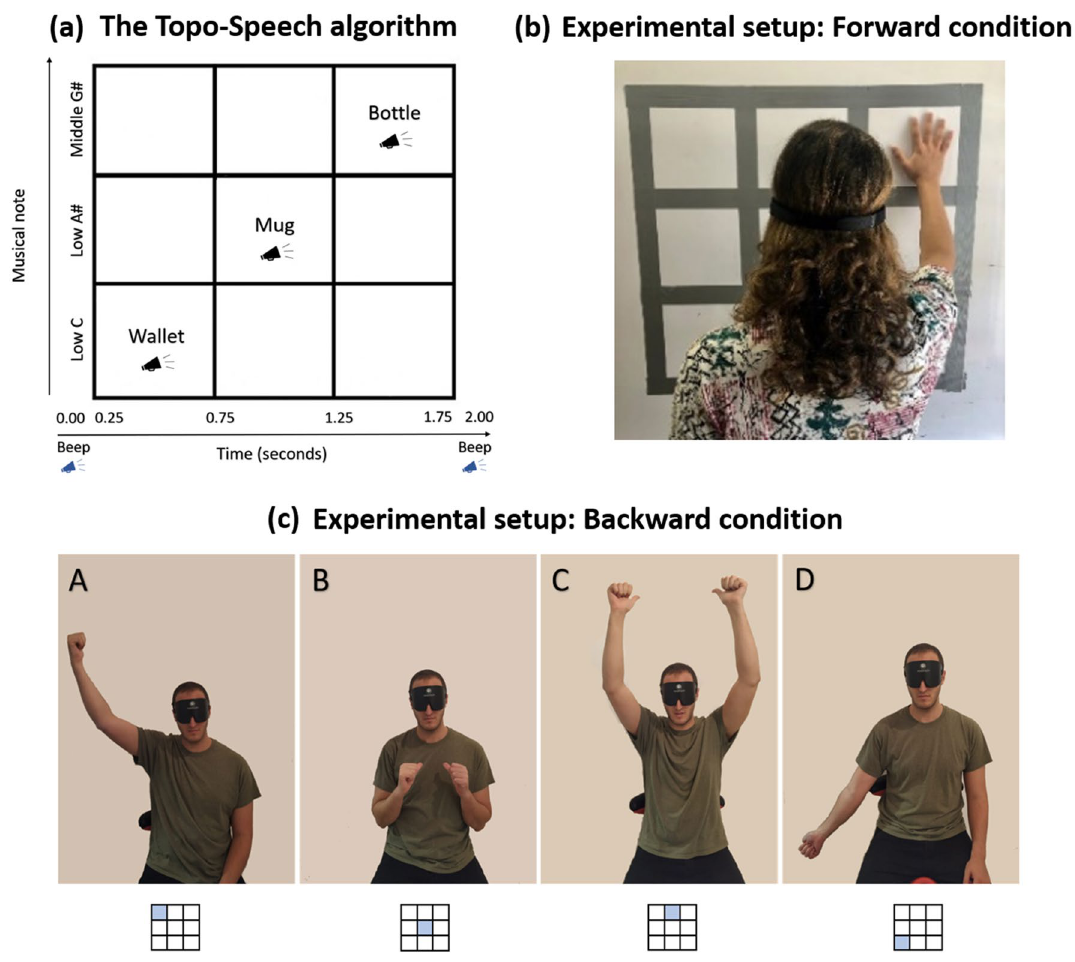
Figure 1. ( a ) Illustration of the Topo-Speech algorithm and of the temporal structure of a trial. ( b ) Illustration of experimental setup in the forward condition. ( c ) Illustration of experimental setup in the backward condition with some of participants’ pointing gestures which they used to provide responses. A—The participant is pointing back to the top right corner of the 3 × 3 grid. B—The participant is pointing back to the central location of the 3 × 3 grid (the middle of both the y-axis and x-axis). C—The participant is pointing back to the top- middle location in the 3 × 3 grid. D—The participant is pointing back to the bottom right corner of the 3 × 3